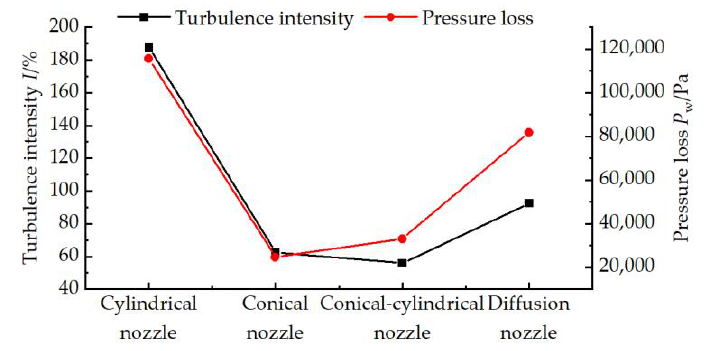
Figure 8. Comparison of nozzle scouring performance.